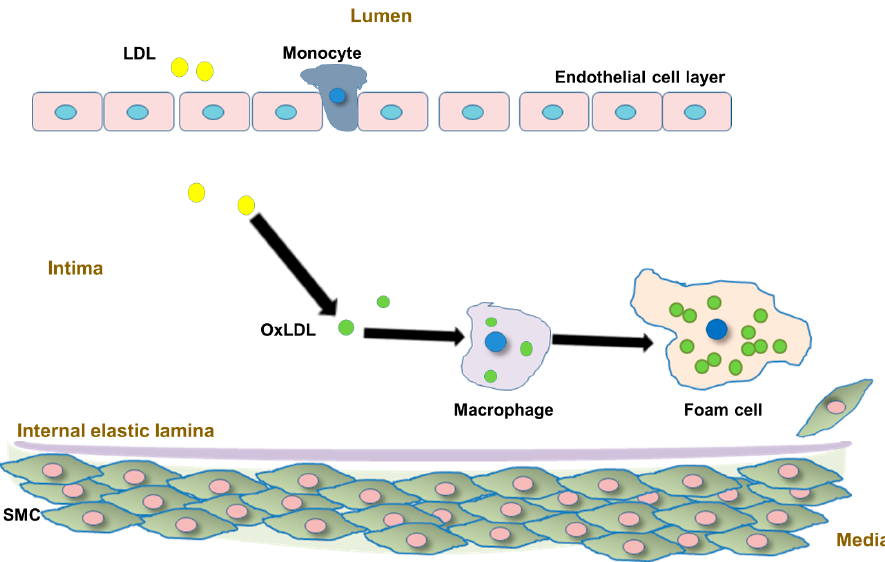
Figure 1. Atherosclerosis involves apoB-containing lipoproteins. The atherosclerotic process begins with compromise of the endothelial barrier, allowing apoB-containing LDL cholesterol to migrate into the arterial intima. Activated endothelium fosters attachment, migration and proliferation of vascular smooth muscle cells (SMC) and macrophages. Retained apoB-containing lipoproteins are oxidatively modified within the vascular intima. Oxidized (ox)LDL contains protein components, creating a net negative charge, making the particles highly attractive to macrophages. Phagocytosis allows for the accumulation of lipids within macrophages, producing foam cells. OxLDL-laden foam cells amass and form the fatty streak and eventually the lumen-narrowing atheromatous plaque that restricts blood flow. Additionally, inflammatory signaling pathways are activated, leading to increased cell migration and LDL modification.